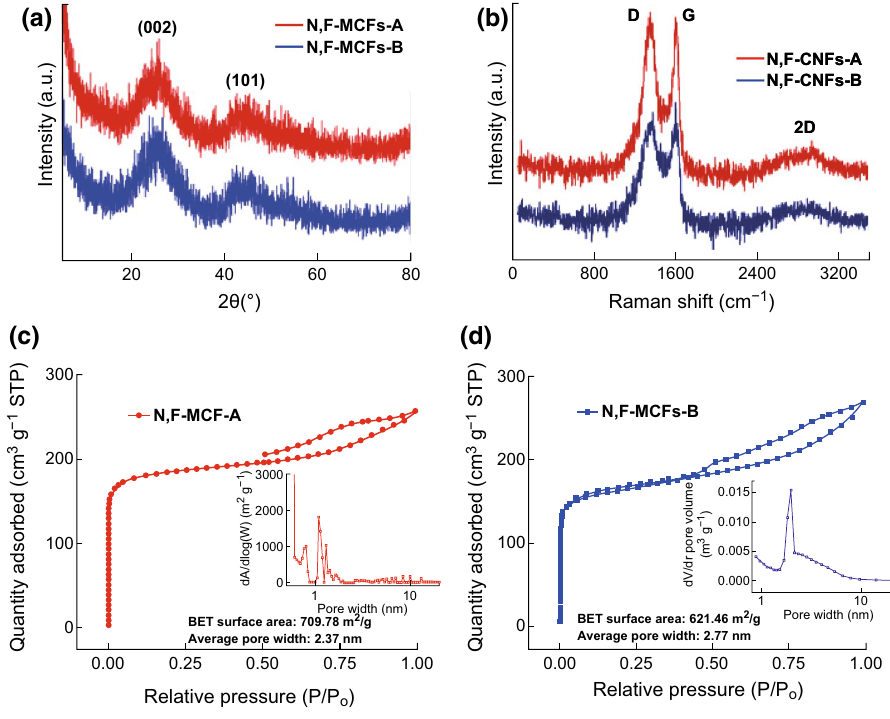
Fig. 2 a XRD patterns, b Raman spectra, c , d N 2 adsorption isotherms (inset of c and d is pore size distributions of N, F-MCFs-A and N,